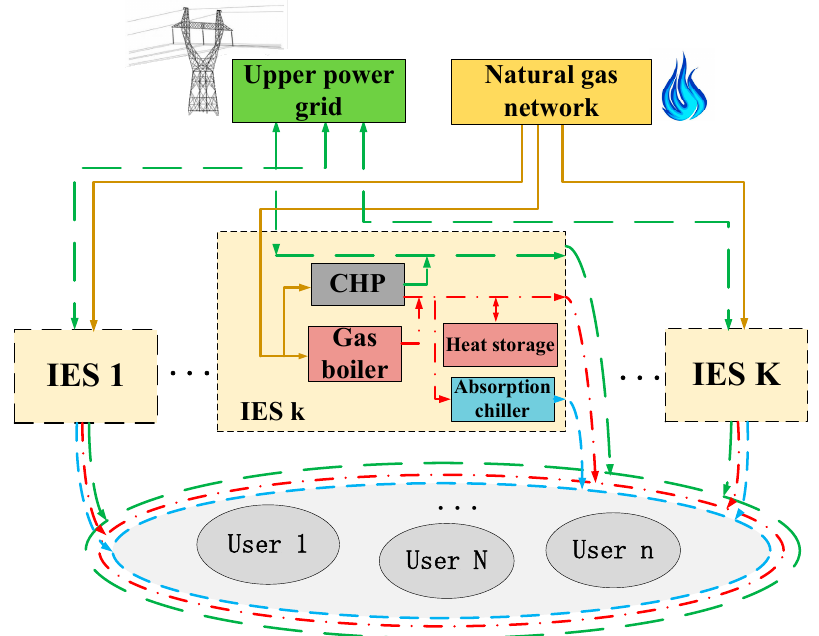
Figure 10. The future pattern of multiple IESs interconnection.